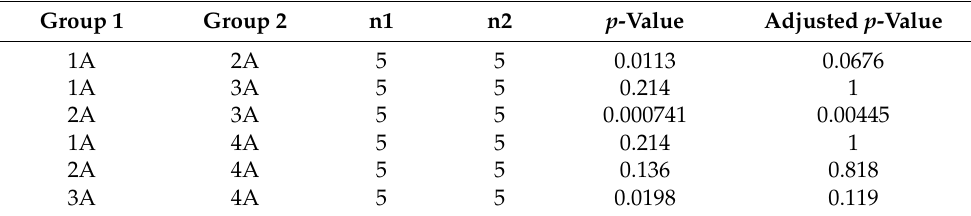
Table 8. Results of Student’s t -test with Bonferroni adjustment.